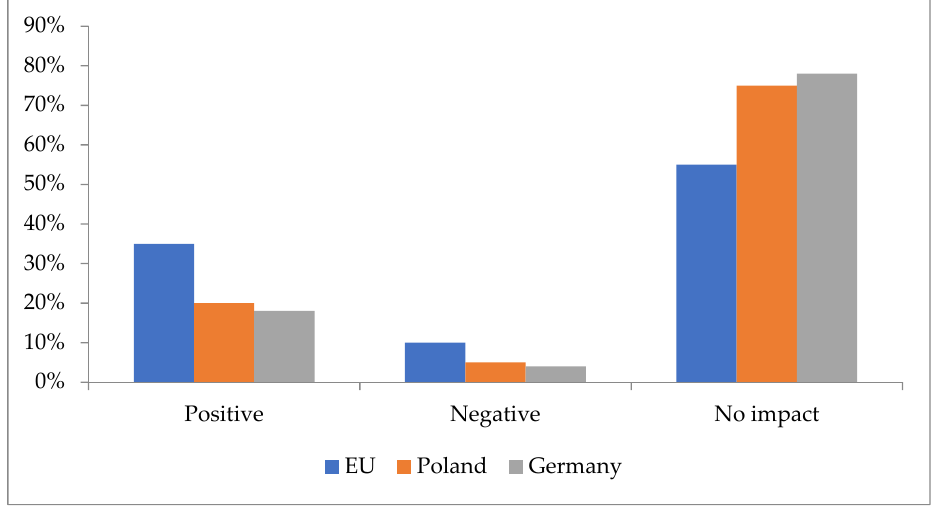
Figure 11. Reputation feedback.